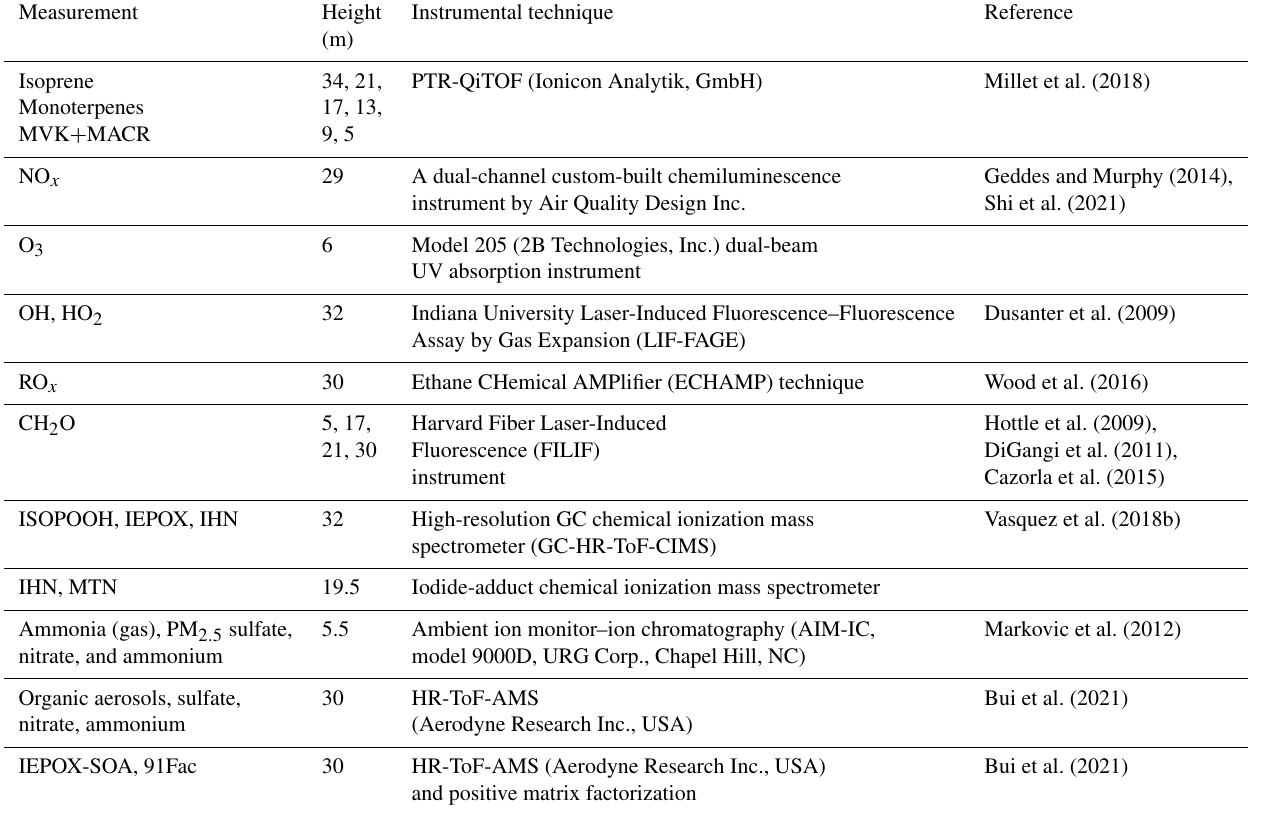
Table 4. 2016 UMBS PROPHET observations utilized in this study for model evaluation, including concentration measurements, measure- ment heights, instrumental techniques, and references. Chemical compound abbreviations are defined as follows: MVK + MACR (methyl vinyl ketone and methacrolein), NO x (nitrogen oxides), O 3 (ozone), OH (hydroxyl radical), HO 2 (hydroperoxy radical), RO x (peroxy rad- ical), CH 2 O (formaldehyde), ISOPOOH (isoprene hydroxy hydroperoxide), IEPOX (isoprene epoxydiol), IHN (isoprene hydroxy nitrate), MTN (monoterpene hydroxy nitrate). IEPOX-SOA and 91Fac represent the isoprene-derived epoxydiol organic aerosols and monoterpene- derived organic aerosols, respectively. The canopy height is